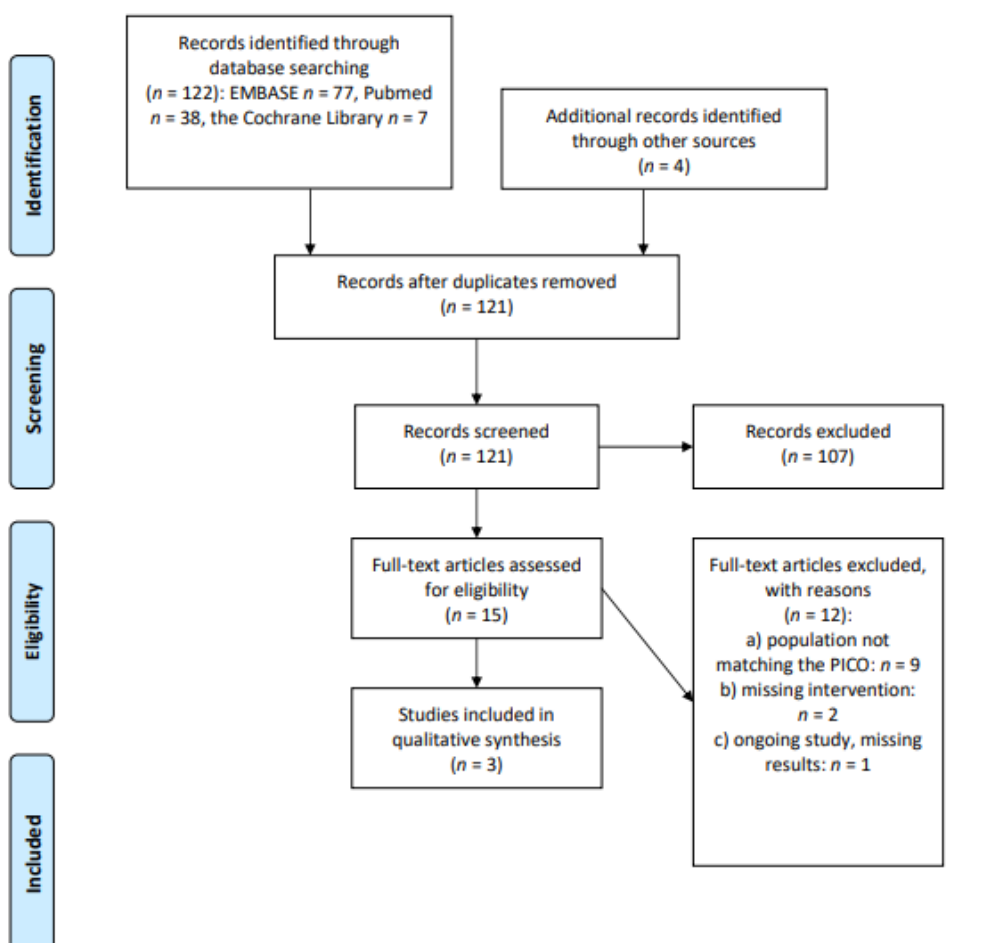
Figure 5. PRISMA flow-chart on preventive measures for chronic fatigue/cognitive impairment.